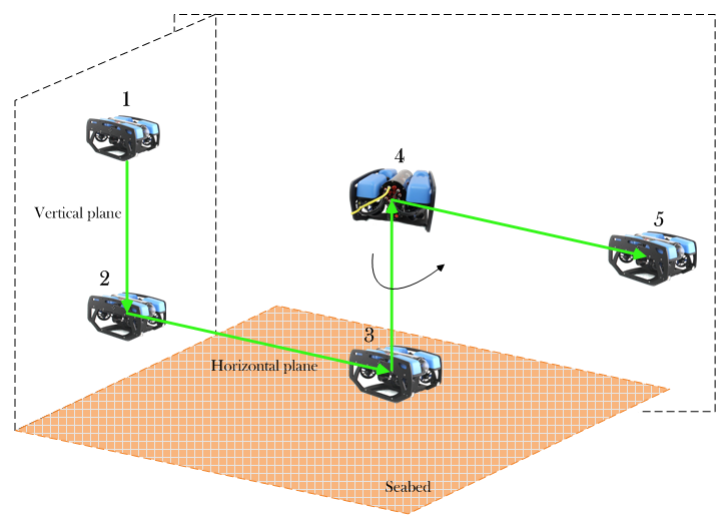
Figure 1. A proposal for submarine pipeline monitoring by using a low-cost unmanned underwater vehicle